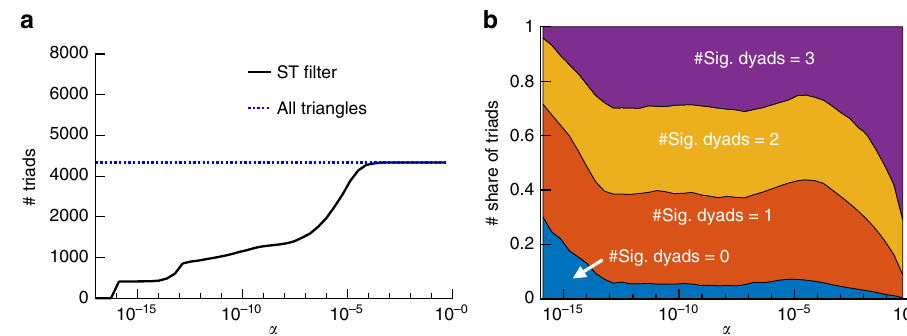
Fig. 6 Signi fi cant triadic relationships in the Highschool data set, for a temporal resolution Δ = 1 min. a Number of signi fi cant triads as a function of α . b Fraction of signi fi cant triadic relationships with a given number of signi fi cant dyads, as a function of